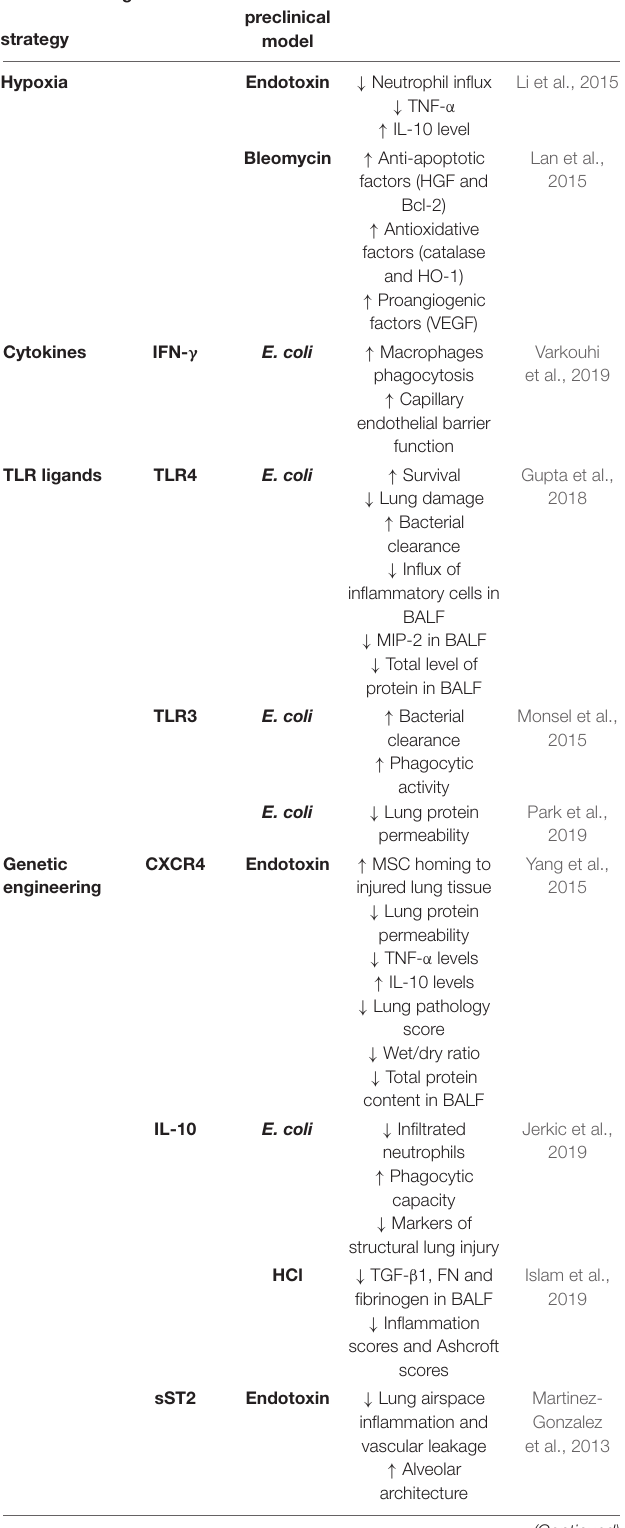
TABLE 4 | Strategies for improving the therapeutic efficacy of MSCs in ARDS/ALI preclinical